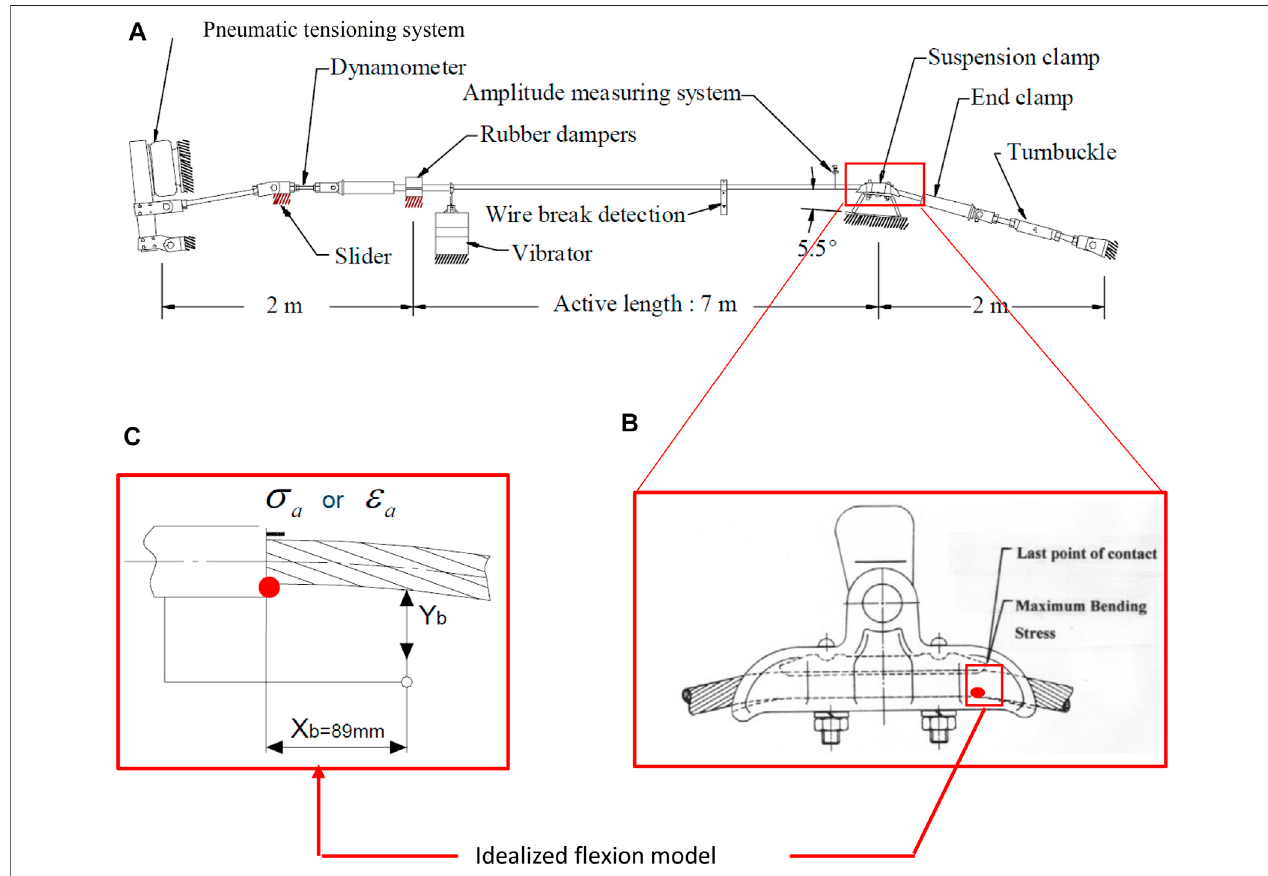
FIGURE 2 | (A) Fatigue testing bench for conductor-clamp systems [adapted from (CIGRE, 2010)]. (B) Conductor-clamp assembly showing region of maximum bending stress (Cloutier and Lalonde, 2007). (C) Simpli fi ed representation of the conductor-clamp assembly and the idealized stress or strain induced by bending amplitude Y b (Cloutier and Lalonde,